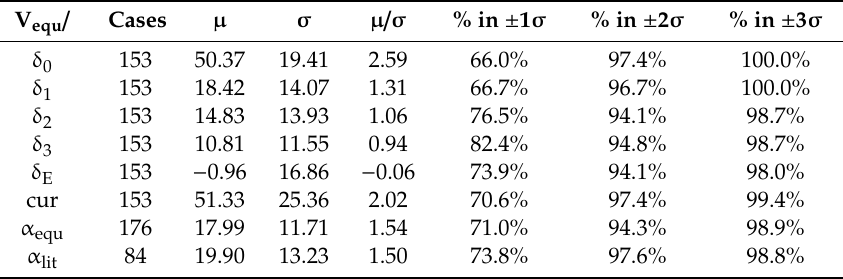
Table 4. Results for the volume-to-parameter correlations for the set “full”. For all shape-related parameters, the mean value ( µ ) with the respective standard deviation ( σ ) and the sample size per sigma interval is